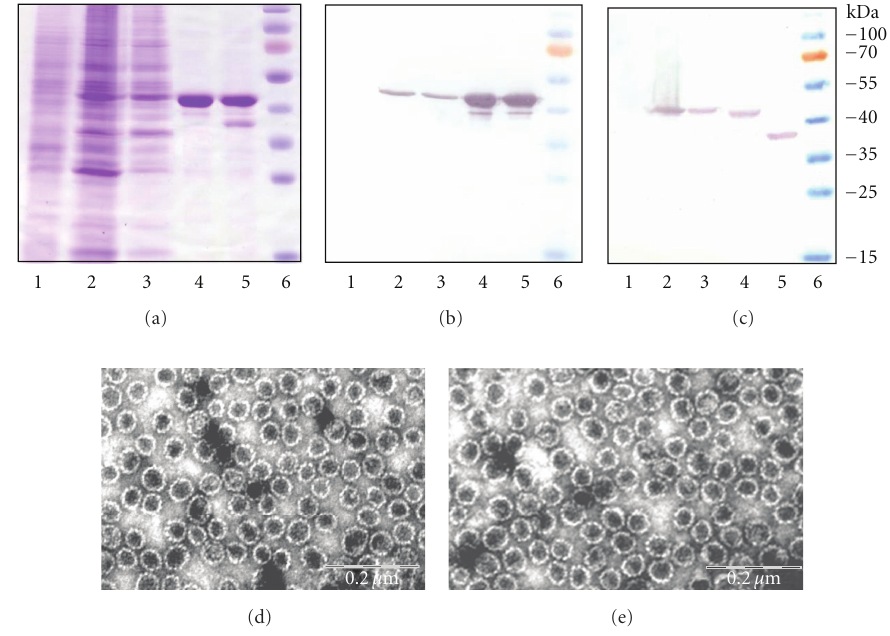
Figure 2: Analysis of the expression of VP1/VP2-p16 INK4A pseudotype VLPs in yeast. (a) Coomassie blue-stained SDS-PAGE. (b) Western blot with the MAb 3D10 against VP1 protein. (c) Western blot with polyclonal antibody against VP2 protein. The same samples were run on each gel. In lanes, there are (1) negative control sample from crude lysate of S. cerevisiae cells transformed with the empty vector pFGG3, (2) crude lysate of yeast transformed with pFGG3-VP1/VP2-p16 plasmid, (3) the soluble fraction recovered after centrifugation of crude lysate of yeast transformed with pFGG3-VP1/VP2-p16 plasmid, (4) VLPs consisting of VP1 protein and fusion protein VP2-p16 purified using sucrose and CsCl gradients, (5) VLPs consisting of VP1 protein and nonmodified VP2 protein purified using sucrose and CsCl gradients, and (6) prestained protein molecular mass marker (Thermo Scientific Fermentas). (d and e) Electron microscopy pictures of VP1/VP2- p16 INK4A (d) and nonmodified VP1/VP2 (e) pseudotype VLPs, stained with 2% aqueous uranyl acetate solution and examined by Morgagni 268 electron